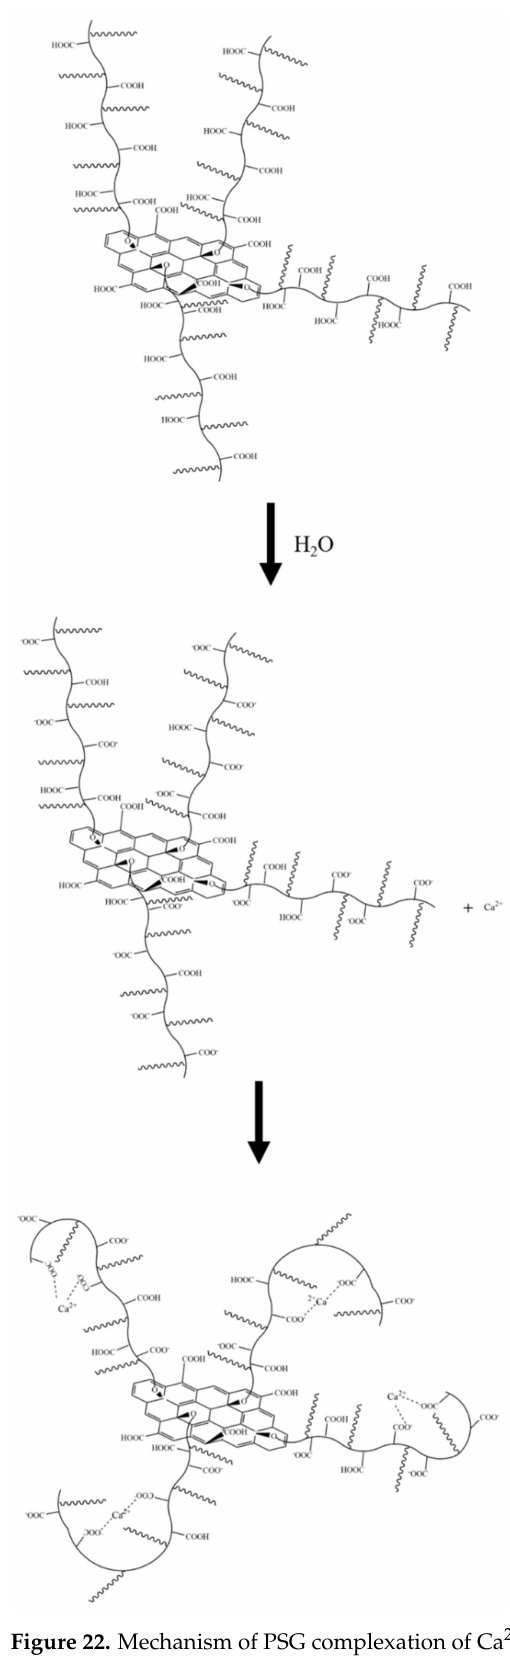
Figure 22. Mechanism of PSG complexation of Ca 2+ in